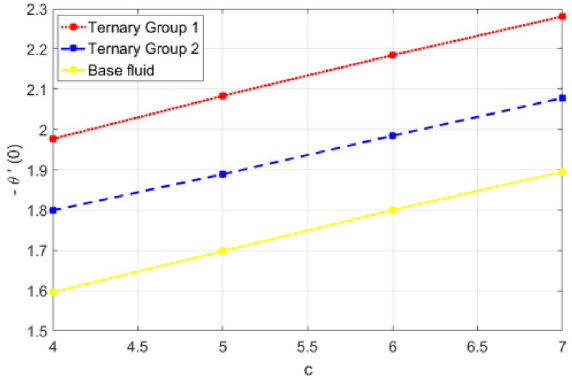
Figure 18. Deviation in Nusselt number against stretching ratio (c).